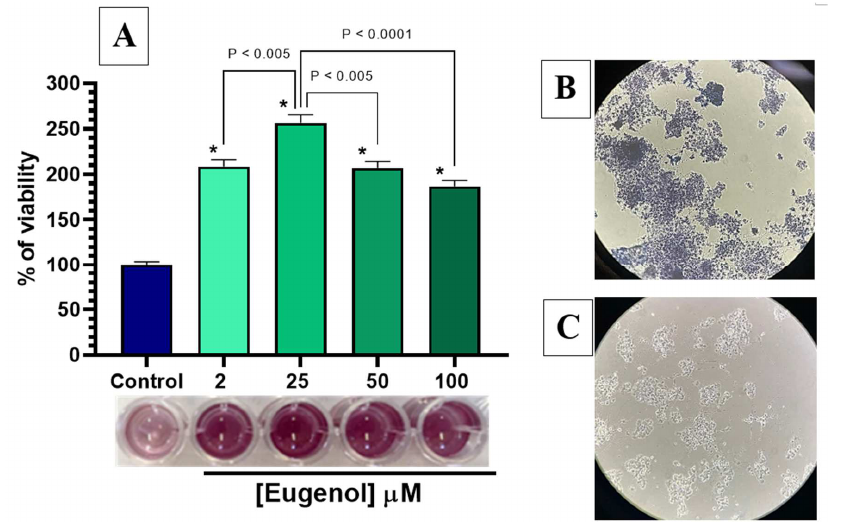
Figure 10. Cell viability of PC12 cells incubated with increasing concentrations of eugenol. ( A ) Data of MTT assay are presented as cell viability percentage (%) normalized to control (non-stimulated) for PC12 cells incubated with 2, 25, 50 and 100 μM eugenol. In the panel below, colorimetric results of the MTT assay are shown; ( B ) PC12 cells containing formazan crystals after incubation with 25 μM eugenol and staining with MTT; ( C ) Untreated PC12 cells differentiated to neuronal phenotype. Data are expressed as mean ± SE of three experiments run in duplicate. Data were statistically ana- lyzed by one-way ANOVA followed by Bonferroni’s post-hoc multiple comparison test. * p < 0.0001 vs. control.